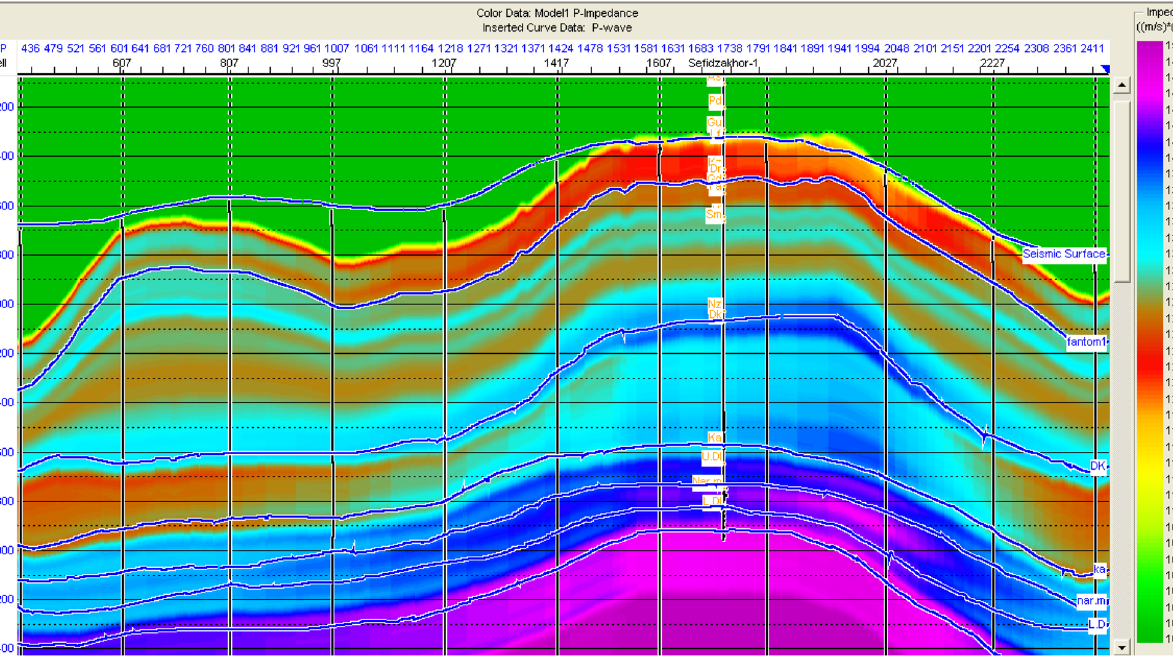
Fig. 4 Initial acoustic impedance model for